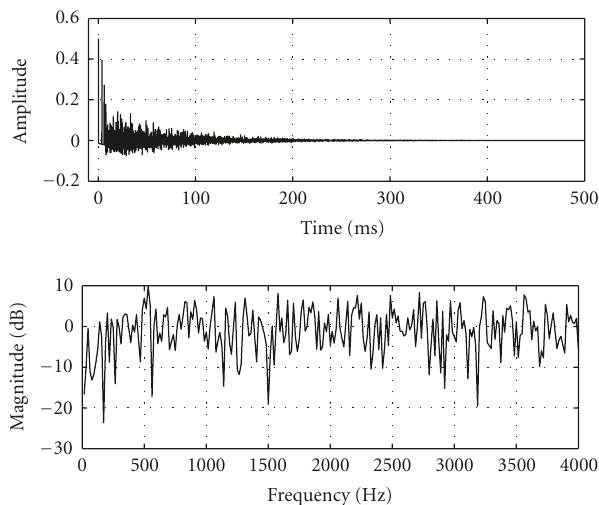
Figure 3: Waveform of a room impulse response h 1 ( n ) and its fre- quency